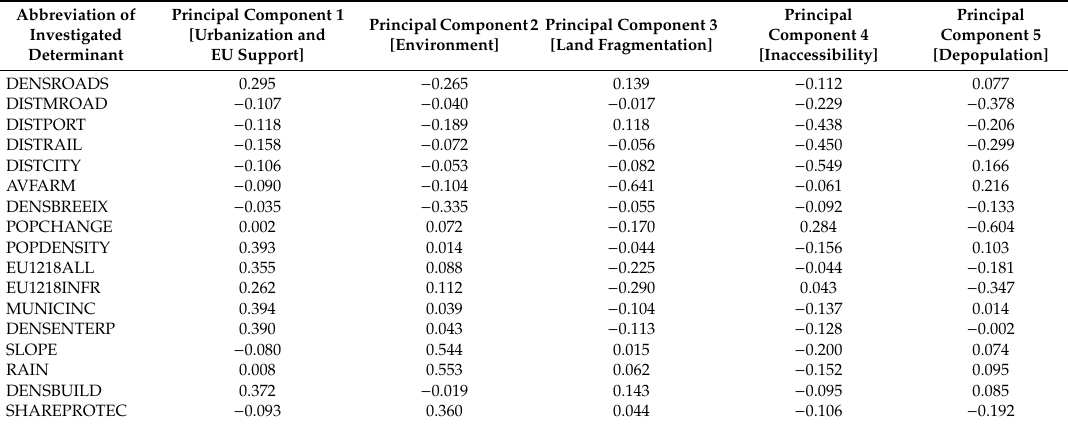
Table 2. Contribution of original determinants of land cover changes to principal